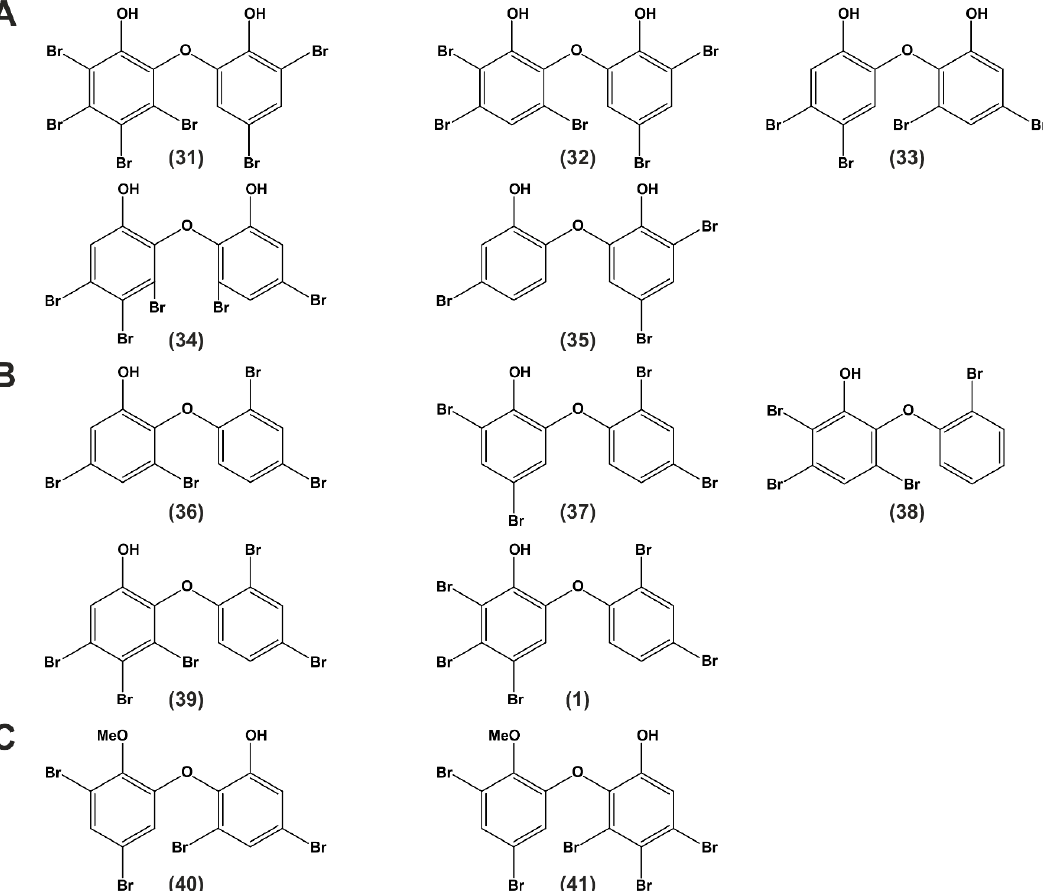
Figure 5. Structures of compounds with reported bioactivity in terms of apoptosis, cytotoxicity, or cancer. ( A ) Published di-OH-PBDEs, ( B ) Published OH-PBDEs, and ( C ) Published MeO-OH-PBDEs. Table 2. Literature summary on bioactivity data of naturally derived and isolated PBDEs in relation to apoptosis and cancer. The literature about PBDEs was screened for data about bioactivity related to apoptosis or cancer cell lines. The corresponding publication is listed together with investigated compounds (structures are shown in Figure 5) and respective biological effects.